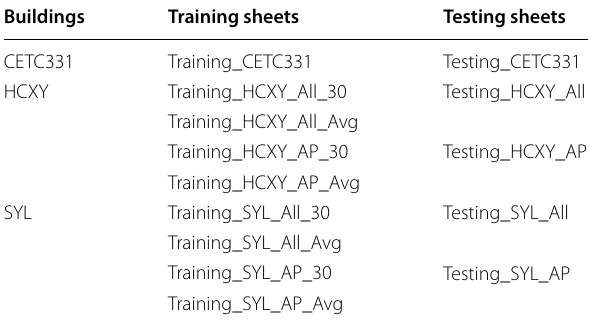
Table 6 Summary of training and testing